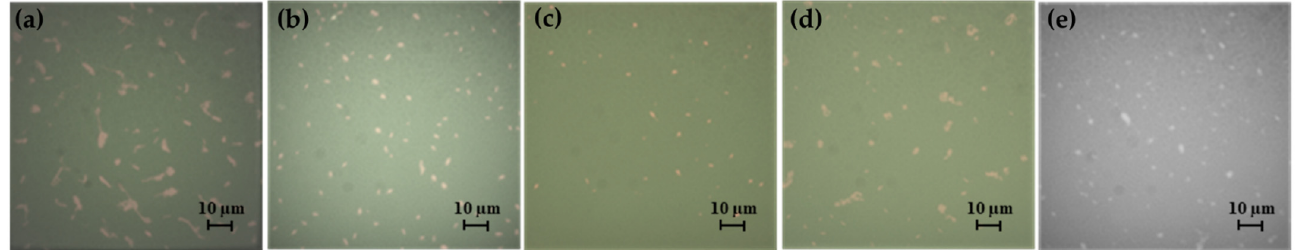
Figure 12. Images of the Gram-negative strain S. maltophilia BC 658 observed with an epifluorescence microscope. ( a ) Control 63×; ( b ) G_A 40×; ( c ) G_A_F3 40×; ( d ) G_A_F16 40×; ( e ) G_A_F3_F16 40×.